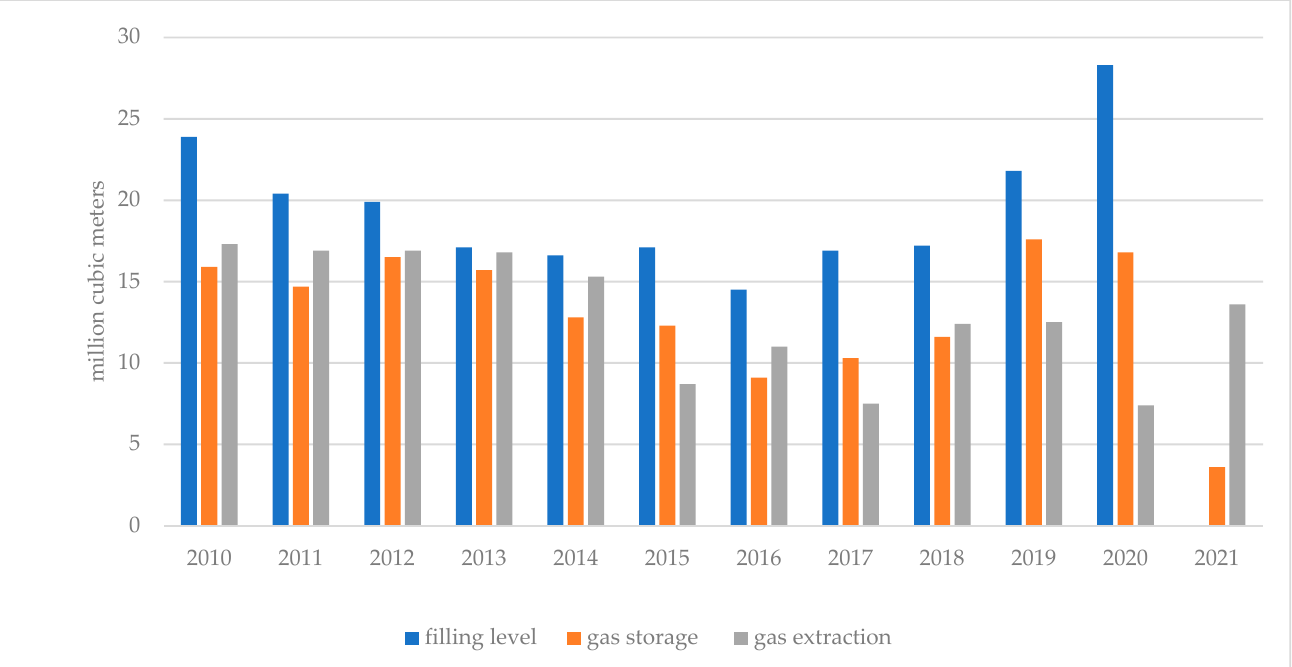
Figure 7. The level of filling, injection, and withdrawal of UGS of Ukraine in 2010–2021. Source: [63]. In 2019, the maximum gas injection volume increased to 21.8 billion m 3 , i.e., free capacity was 10 billion m 3 . The record year was 2020, when the highest level in the last 10 years in terms of injection volumes (28.3 billion m 3 ) was reached. And a third of these stocks were created by foreign customers, most of whom were from EU countries [63].